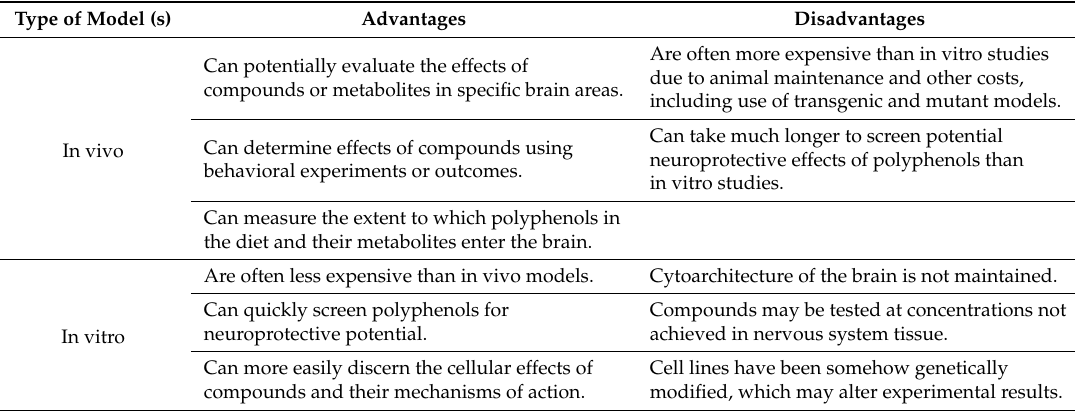
Table 1. Advantages and disadvantages to in vivo and in vitro experimental approaches to studying polyphenols in models of